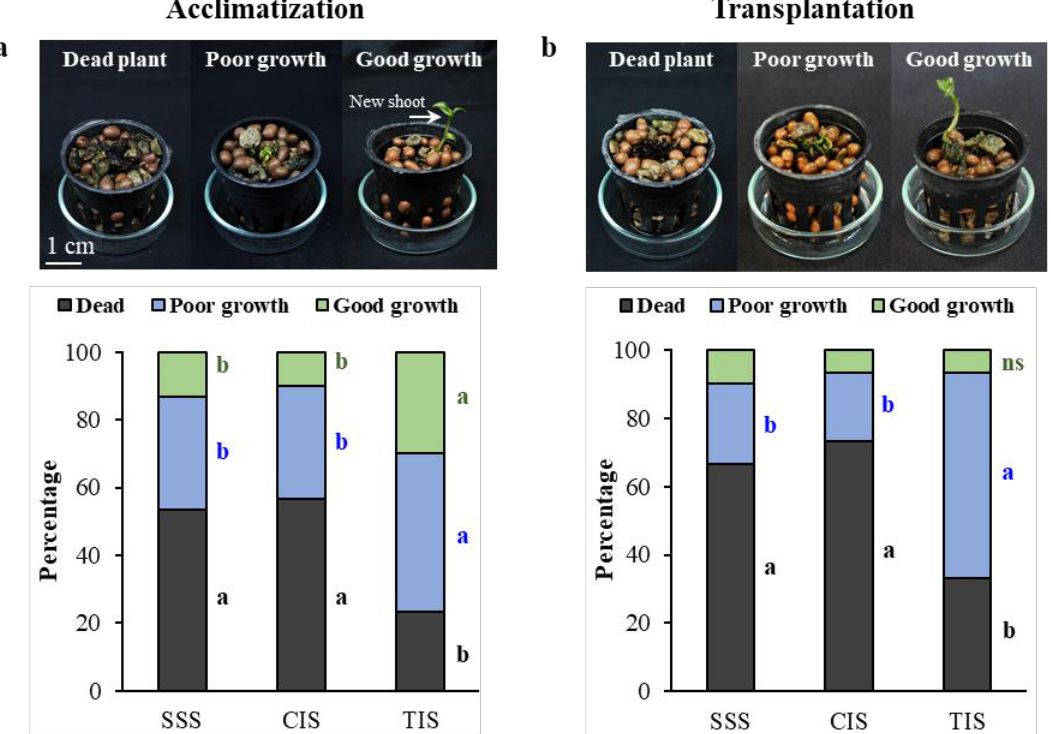
Figure 3. Plant quality and growth of Epipactis flava after acclimatization for nine weeks ( a ) and after transplantation within an artificial stream for eight weeks ( b ). Results are the mean of three replications (20 plants per replication). The same letter of each observation parameter was not significantly different at p ≤ 0.05 according to DMRT.